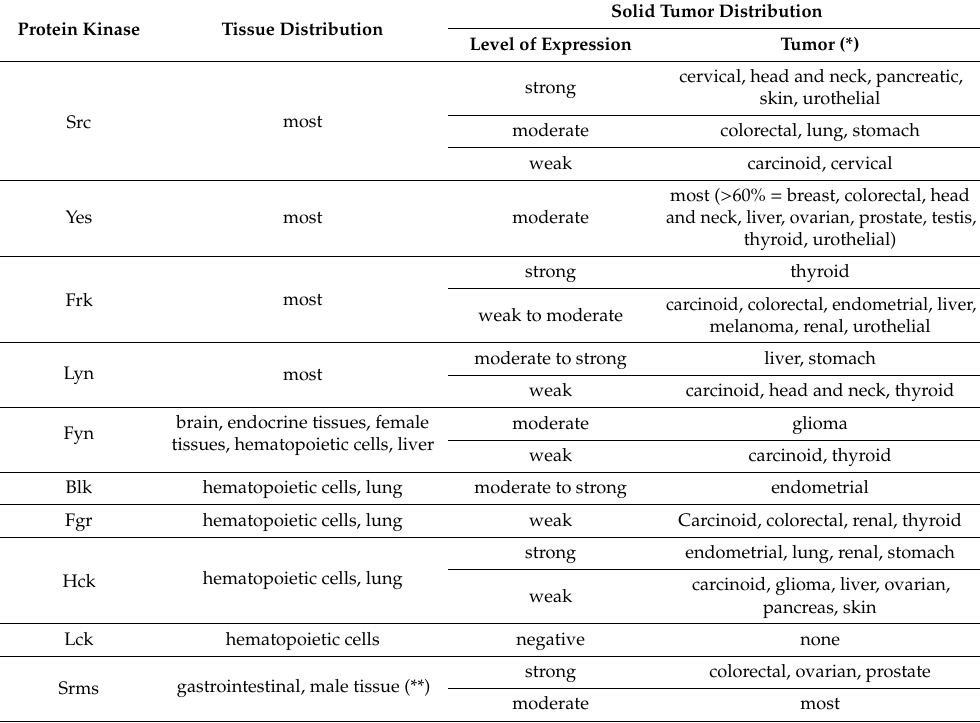
Table 1. Distribution of Src Family tyrosine Kinase (SFK) proteins in normal and solid tumor tissues according to Human Protein Atlas database available from http: // www.proteinatlas.org. Solid Tumor Distribution Protein Kinase Tissue Distribution Level of